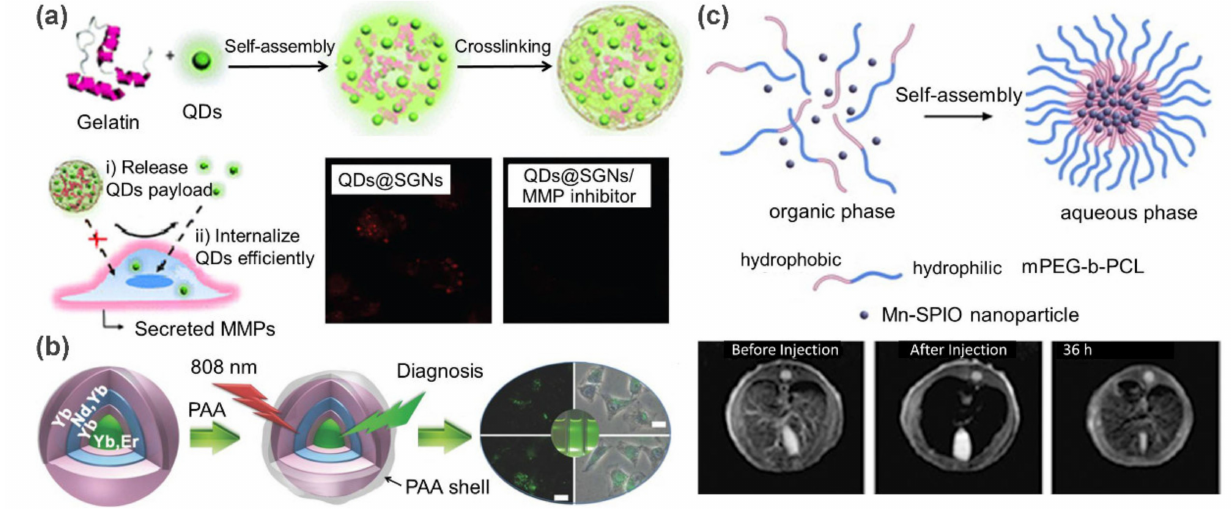
Figure 6. ( a ) Schematic illustration of the preparation of CdSe quantum dots encapsulated supramolecular gelatin nanoparti- cles. Fluorescent confocal microscopic images demonstrated that QDs were released and further internalized by cancer cells. ( b ) Schematic illustration of the preparation of core-shell UCNP@PAA nanoparticles and their application in fluorescence imaging. ( c ) The formation of hybrid micelles via self-assembly of Mn-doped superparamagnetic iron oxide (Mn-SPIO) nanoparticles and amphiphilic polymer (mPEG– b –PCL). MRI imaging results with the Mn-SPIO micelles. Adapted with permission from Refs. [49–51].